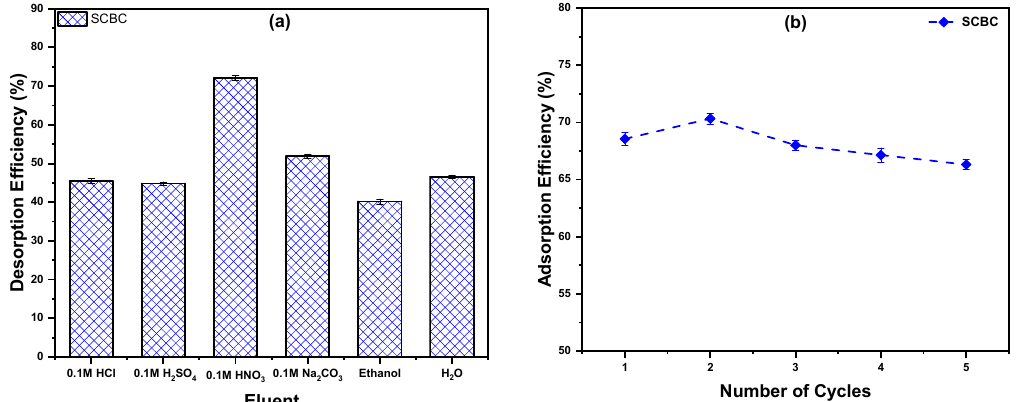
Figure 11. ( a ) Effect of the eluent type on the BALX desorption from the SCBC, and ( b ) the regeneration performance of SCBC for BALX removal.